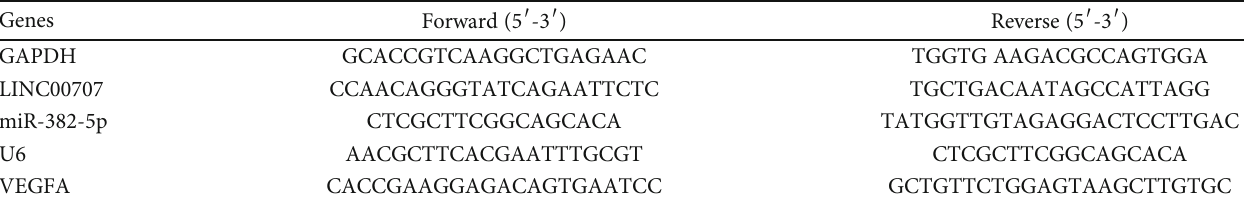
Table 1: Primers used for real-time PCR. Genes Forward (5 ′ -3 ′